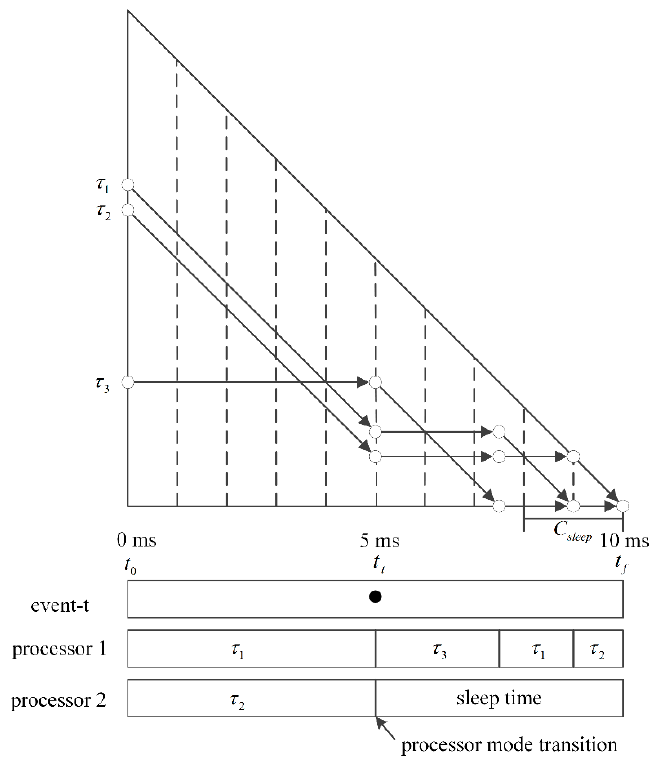
Figure 4. Example of the occurrence of an event-t.